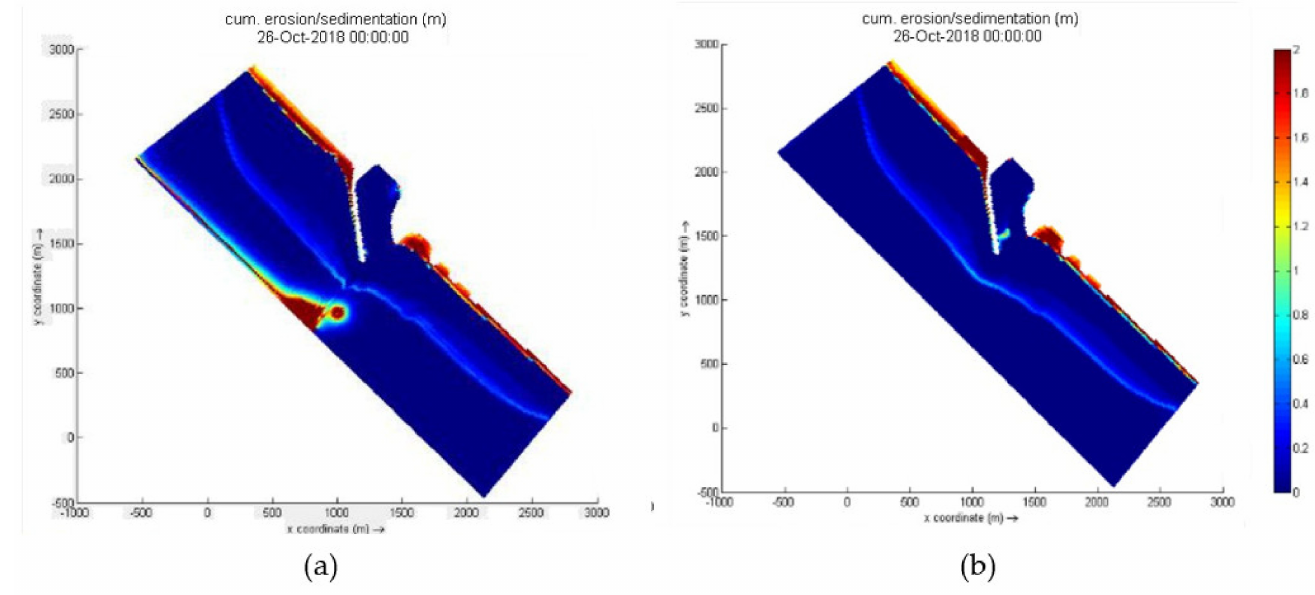
Figure 14. Dredging and dumping modeling: ( a ) scenario 1 and ( b ) scenario